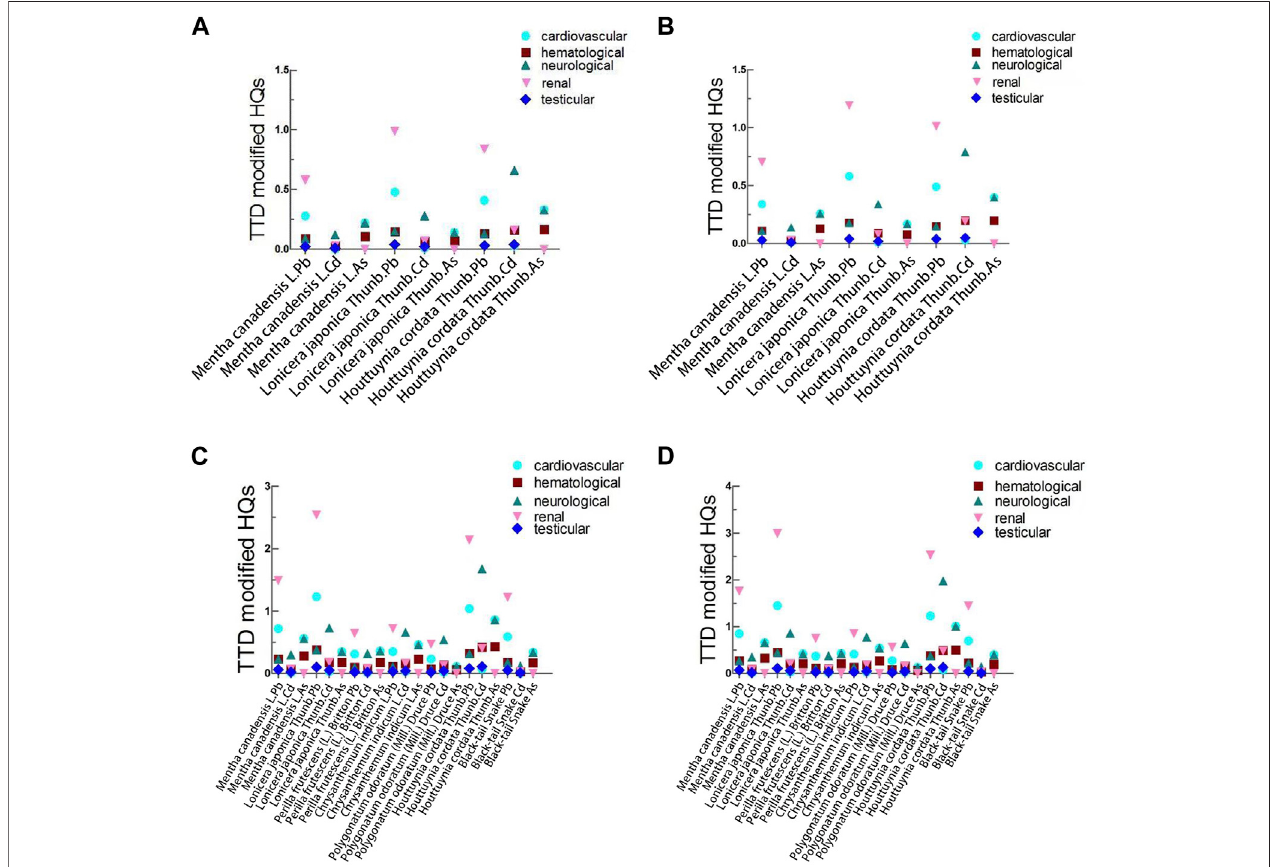
FIGURE 3 | TTD modi fi cation of HI. (A) TTD modi fi cation of HI for food homologous TCM used as TCM for male. (B) TTD modi fi cation of HI for food homologous TCMusedasTCMforfemale. (C) TTDmodi fi cationofHIforfoodhomologousTCMusedasfoodformale. (D) TTDmodi fi cationofHIforfoodhomologousTCMusedas food for